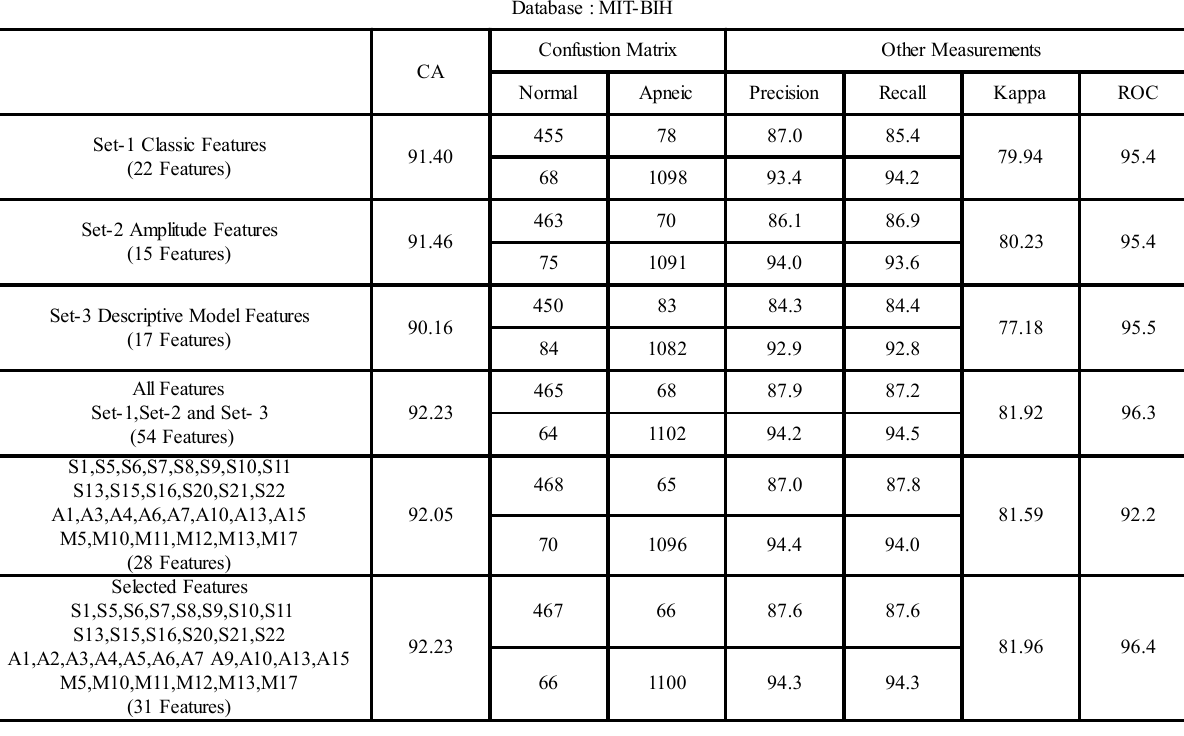
TABLE 5. CLASSIFICATION RESULTS OF FEATURES SETS FOR MIT-BIH DATABASE